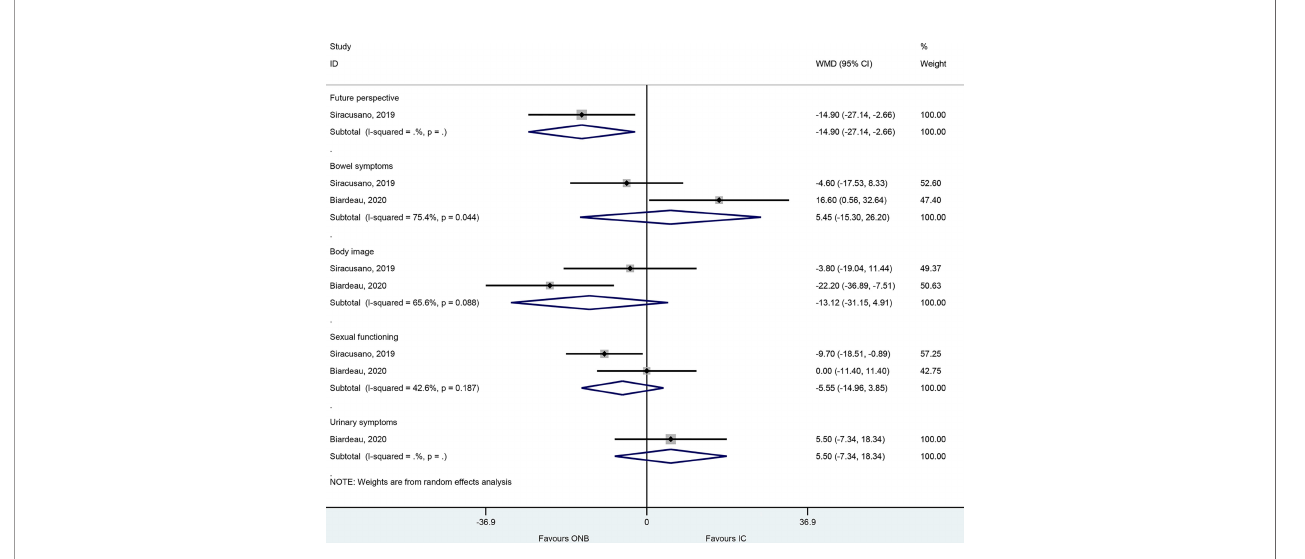
FIGURE 4 | Forest plot of EORTC-QLQ-BLM30 in women with bladder cancer who underwent ileal conduit diversion (IC) or orthotopic neobladder